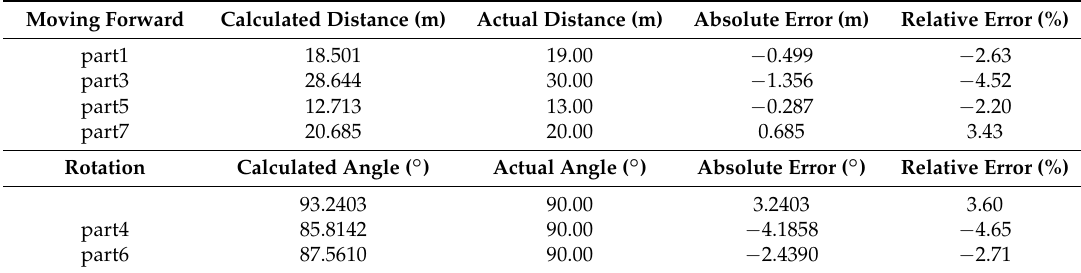
Table 5. Calculated Moving Distance and Rotation Angle of square route test.